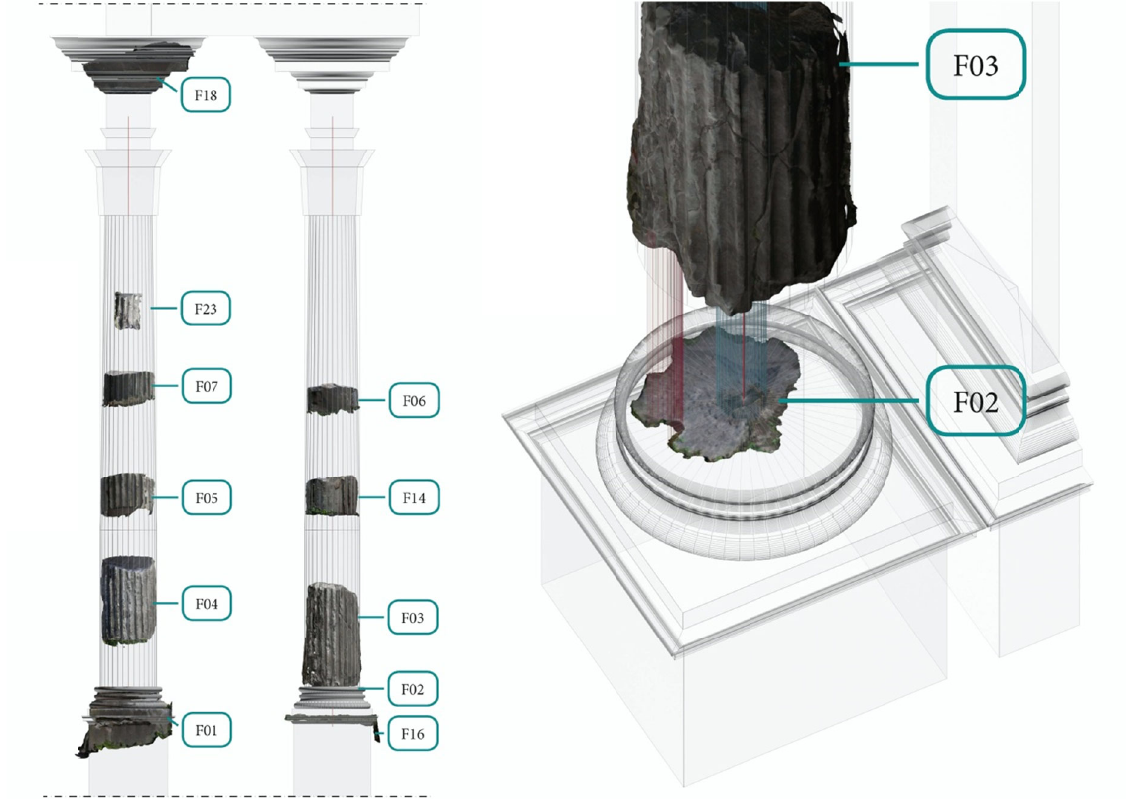
es 4 and 5. Virtu ual Anastylosis s of the Arch of f Titus. Repositi ioning of the fra agments found in the excavatio hypothetica al three-dimens sional model of f the original sh hape of the Arch h: the front view w of two column detail of exp ploded axonome etric view of the e right column base (F02) and the nearest colu lumn drum (F03